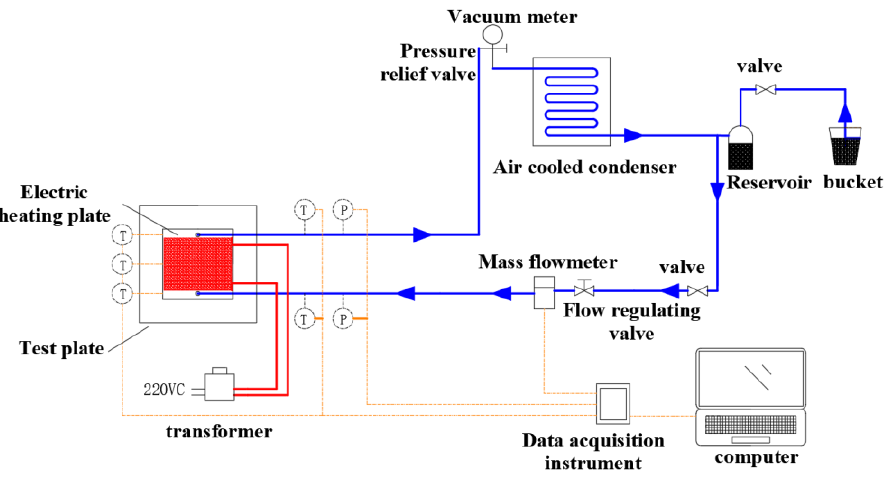
Figure 2. Schematic diagram of the experimental setup.